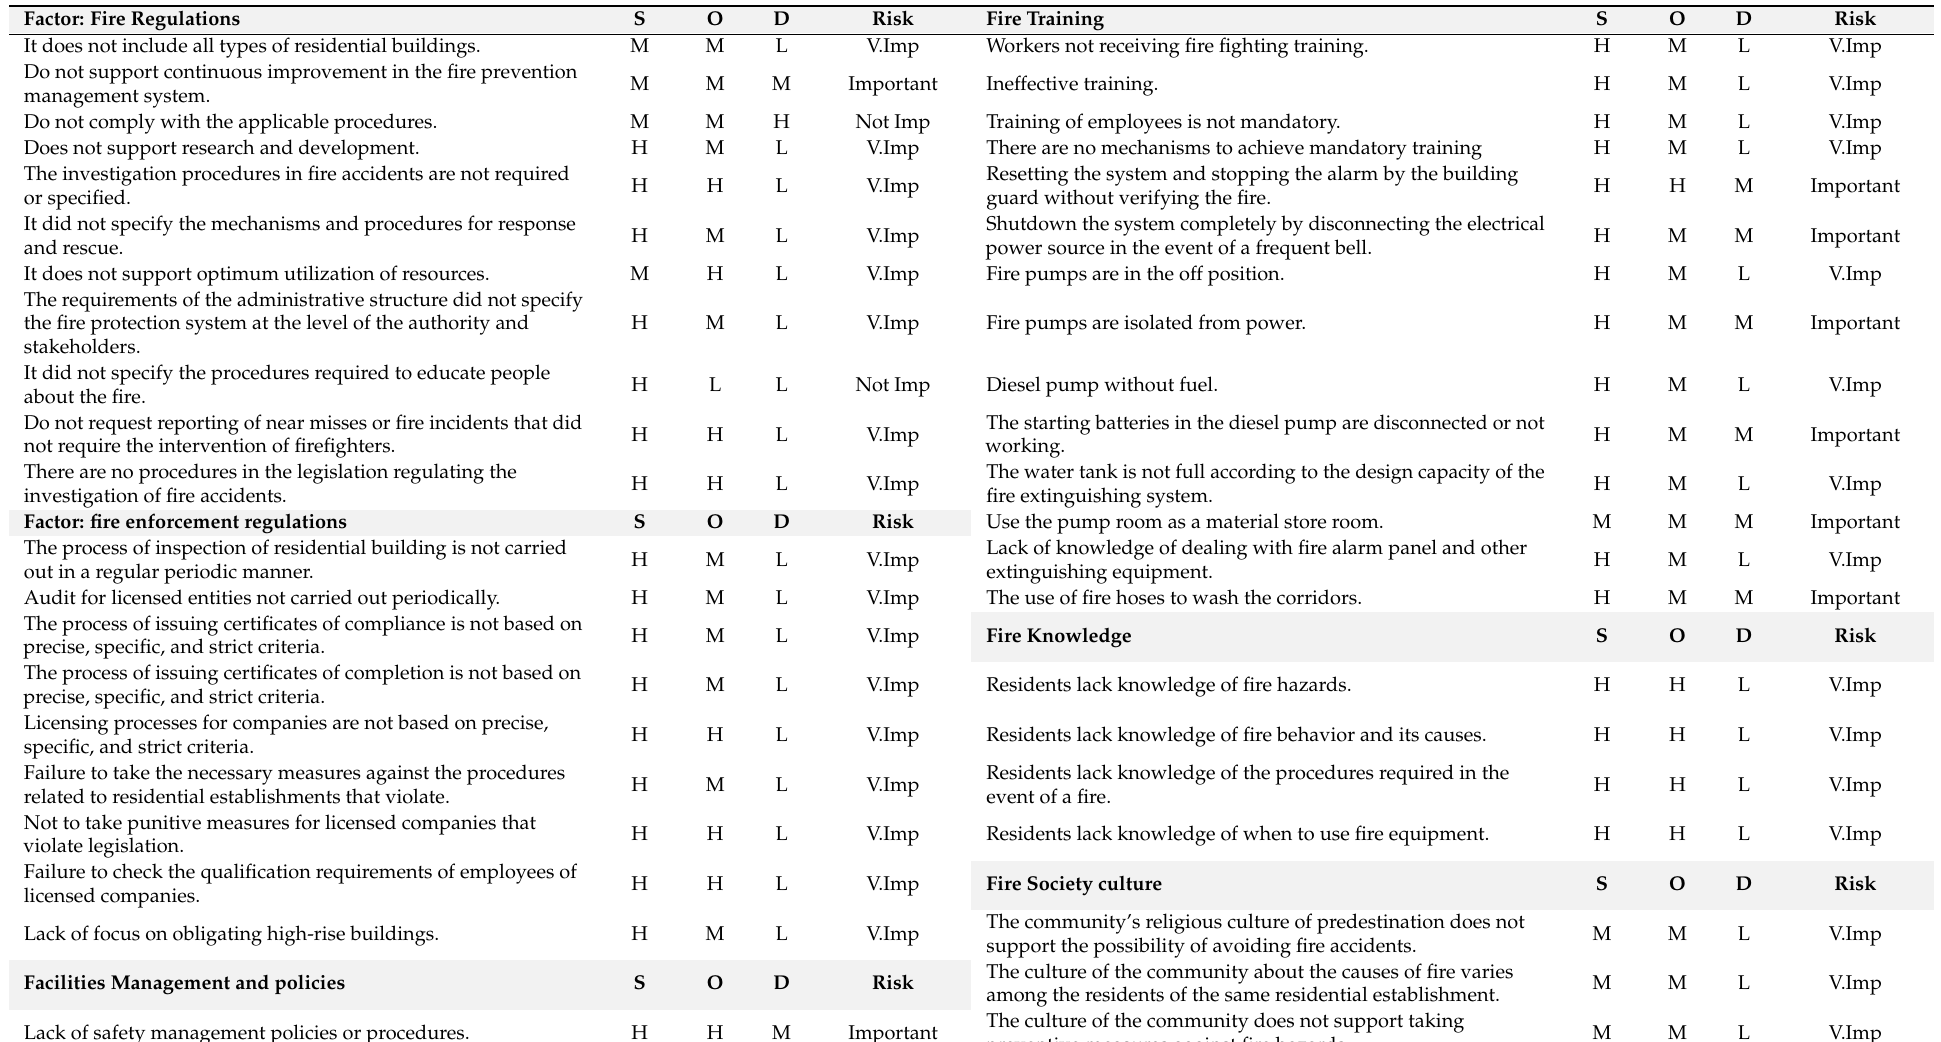
Table 6. Failure mode effect criticality